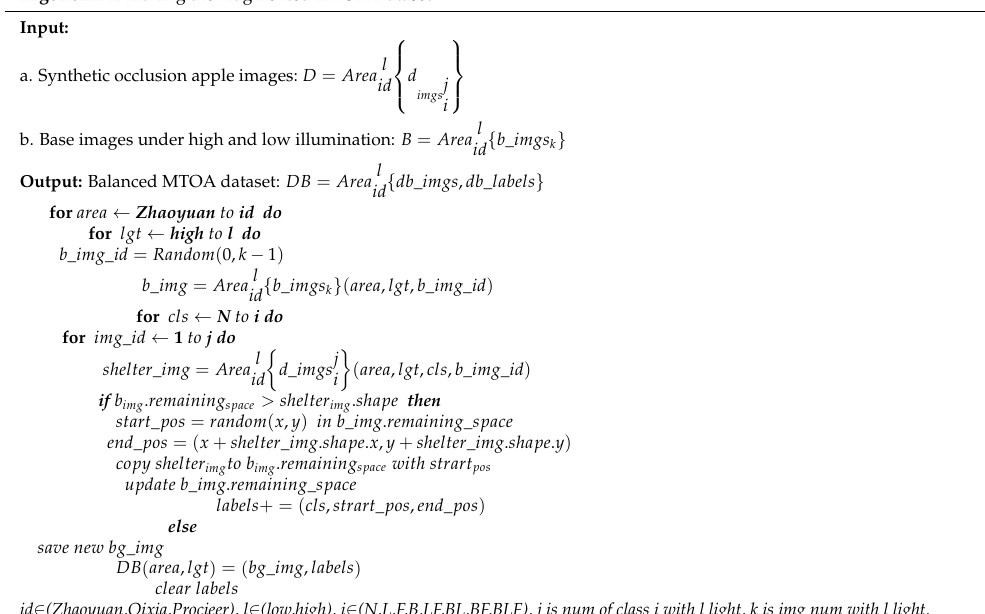
Algorithm 1: Making the Augmented MTOA Dataset